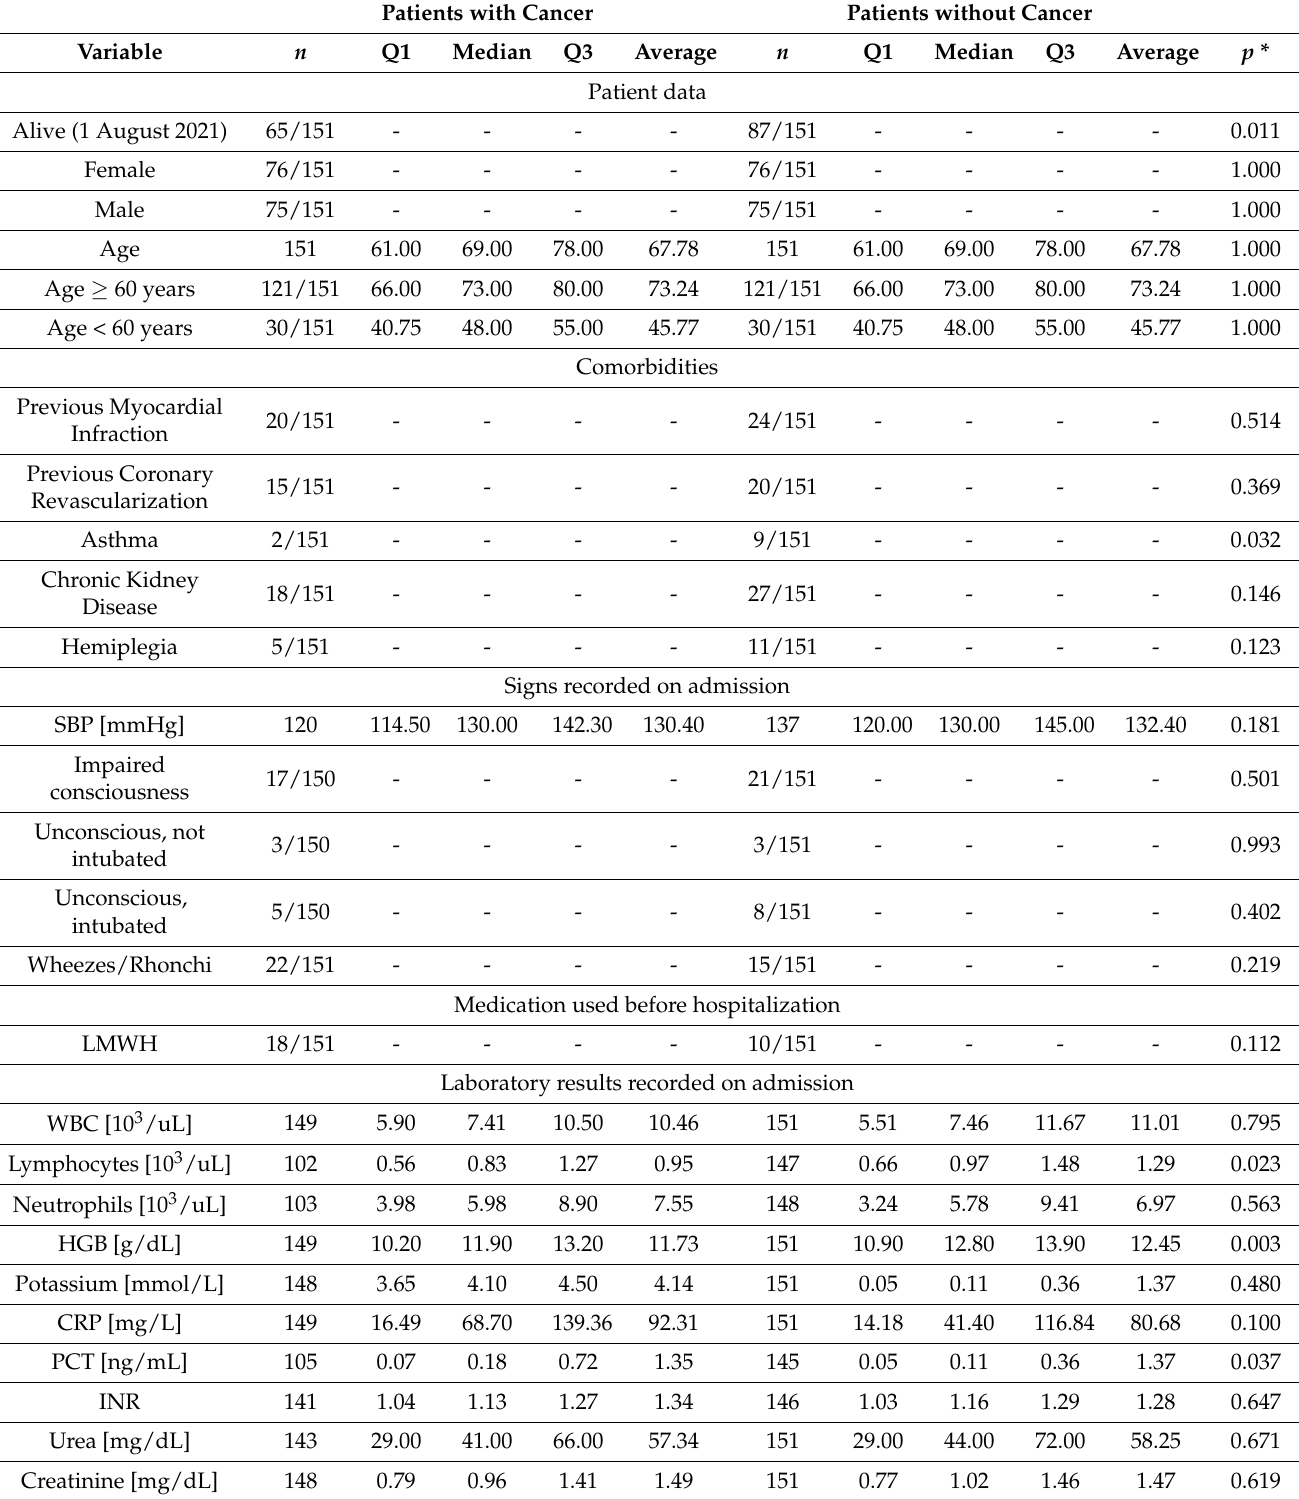
Table 1. Clinical and demographic characteristics on oncological and non-oncological patients hospitalized due to COVID-19. The table presents only variables included in the study (variables affecting the risk of death with p < 0.05 are presented in Table